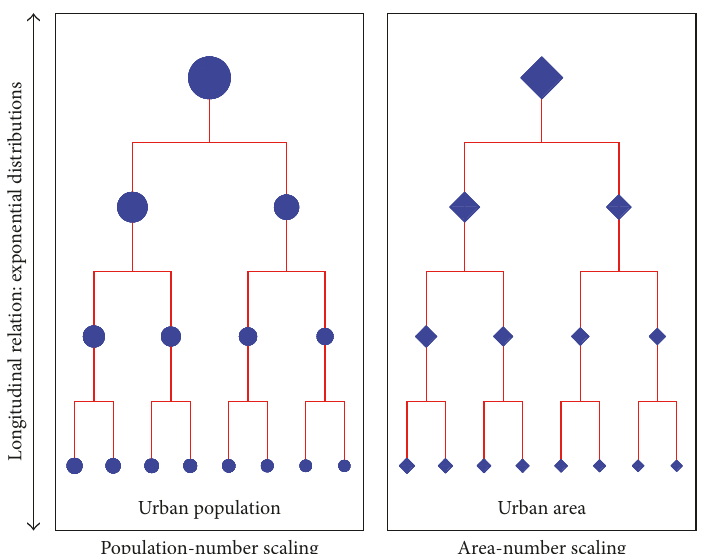
Figure 1: A schematic diagram on the longitudinal distributions and latitudinal allometry of an urban hierarchy measured by population size and urban area (the first four classes). [ Note . See the appendices of